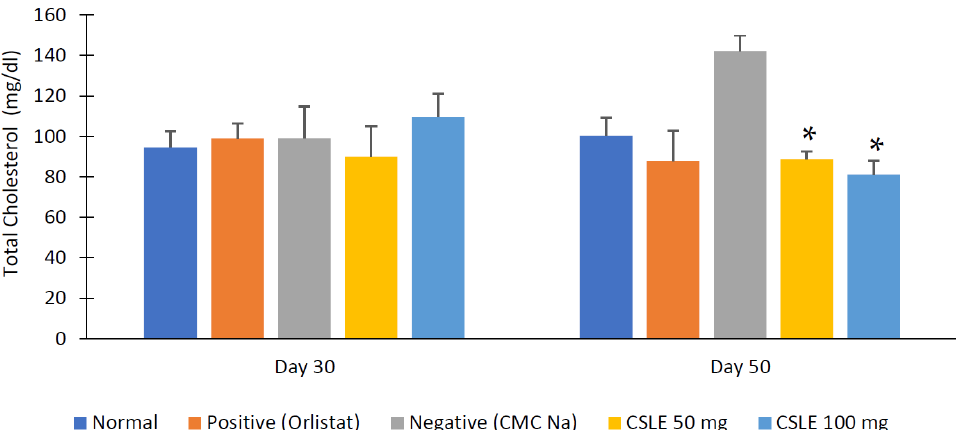
Figure 7. Total blood cholesterol diagram. Data represent mean ± SD ( n = 5). The CSLE dose 50 and 100 mg/kgbw and orlistat group are not significantly different (* p < 0.05) by the ANOVA test.